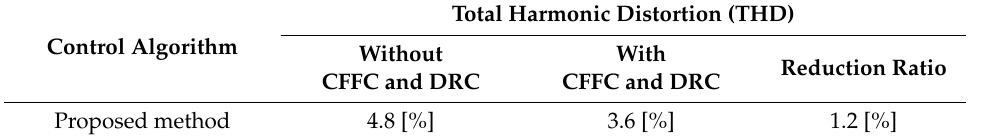
Table 5. Experiment results of GCI system phase current total harmonic distortion (THD) in normal grid condition.